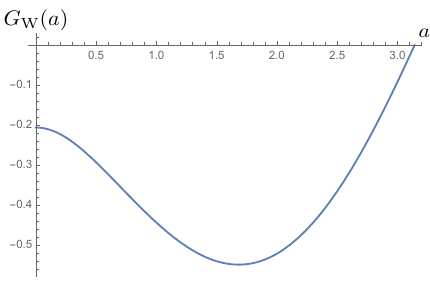
Figure 7 . Plot of the function G W ( a ) . T 0